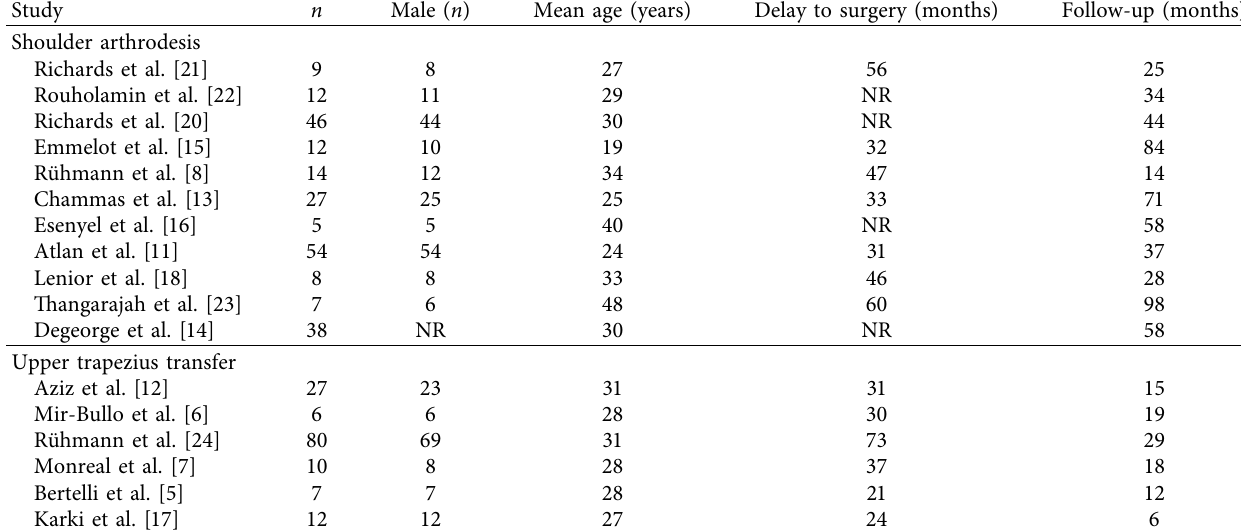
Figure 1: Flowchart illustrating the article selection and exclusion process for the systematic review and meta-analysis. Table 1: Baseline study and patient characteristics ∗ .